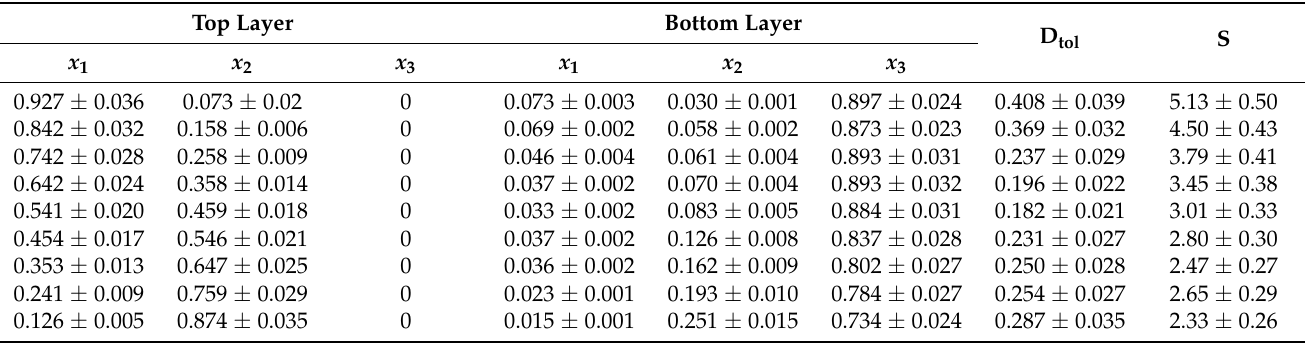
Table 8. Composition of the experimental tie-lines (mole fraction), the toluene distribution ratio (D) and selectivity (S) for the ternary system {1-hexene (1) + toluene (2) + DES #3 (3)} at 298.15 K and 101.325 kPa a